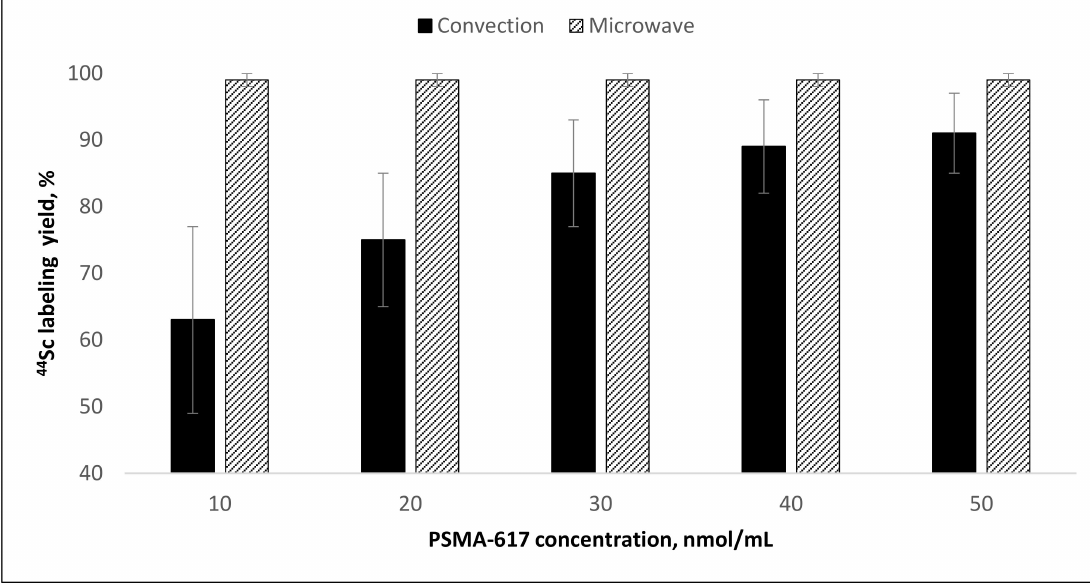
Figure 9. The dependence of 44 Sc radiolabeling yields (mean ± SD, %; n = 5) for PSMA-617 on precursor amount and heating mode (after reformulation of 44 Sc with Presep ® PolyChelate into 0.1 M HCl). Experimental conditions: 95 ◦ C, 30 min, V = 1.0 mL, pH =